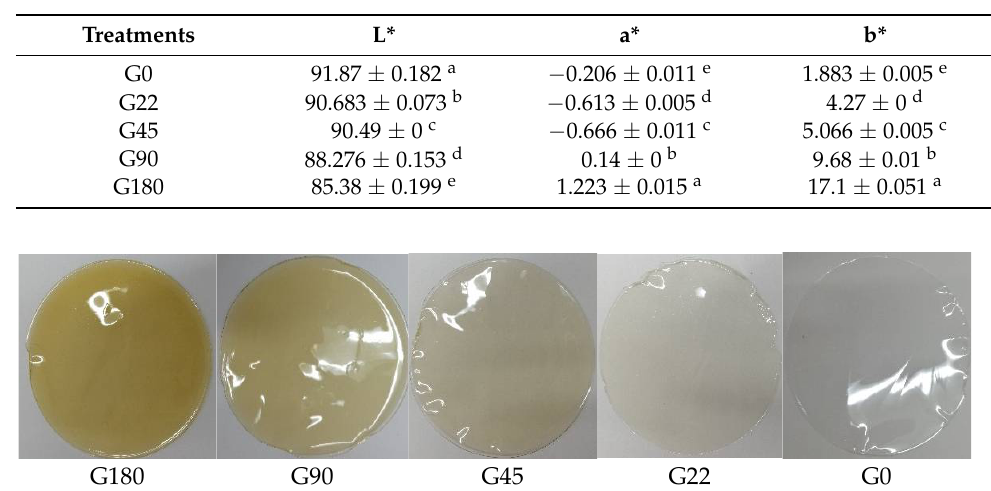
Table 3. CIELab color parameters obtained in the gelatin-based films. Different letters represent significant differences ( p < 0.05).